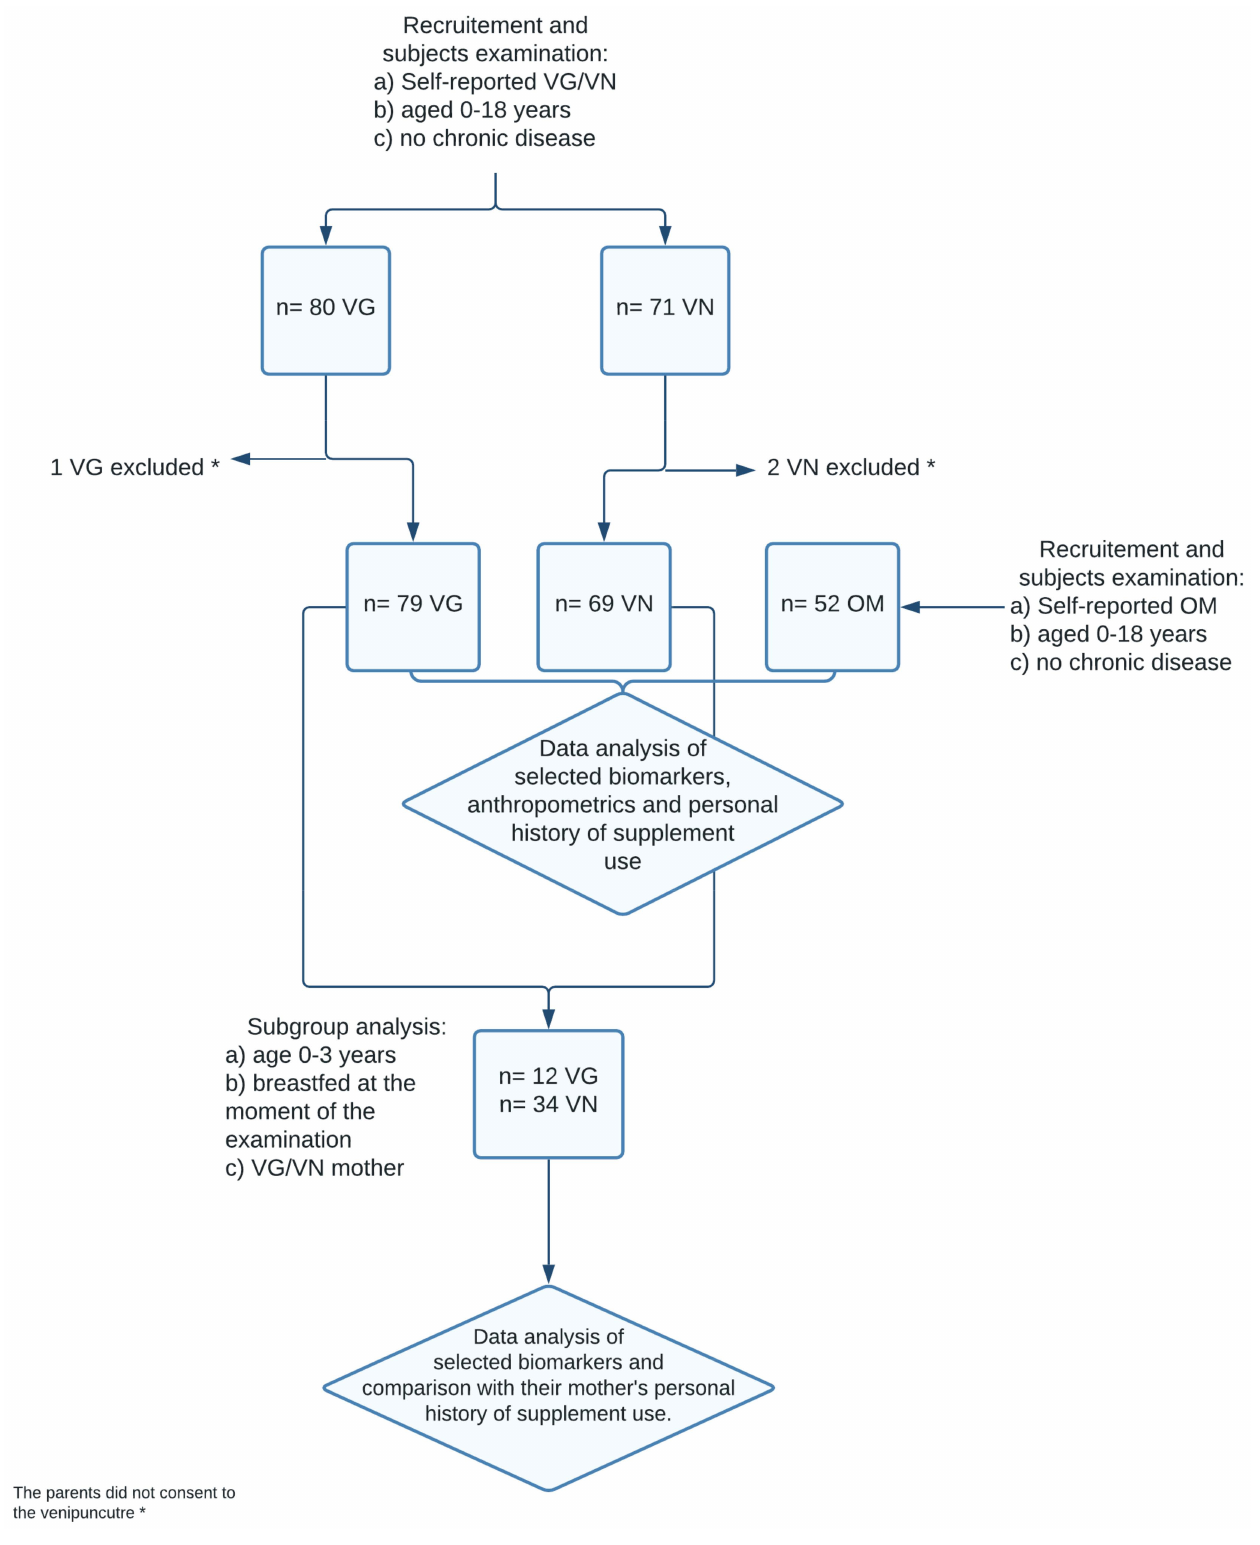
Figure 1. Flow chart of the study